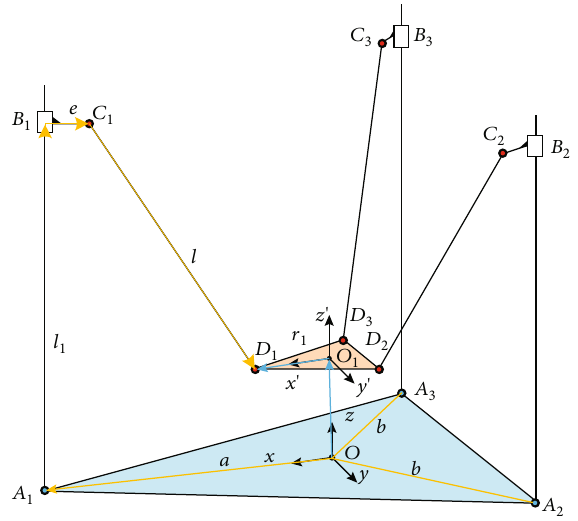
Figure 3: The schematic for the parallel